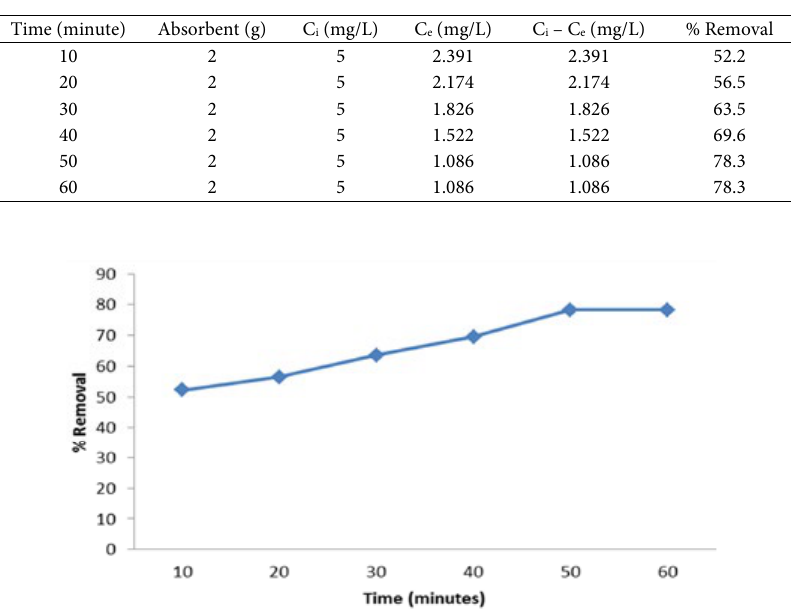
Fig. 3. Effect of contact time graph for fluoride at adsorbent dose 2.0 g, initial fluoride concentration of 5 mg/L, temperature of 25 o C, various contact times of 10, 20, 30, 40, and 50 minutes,